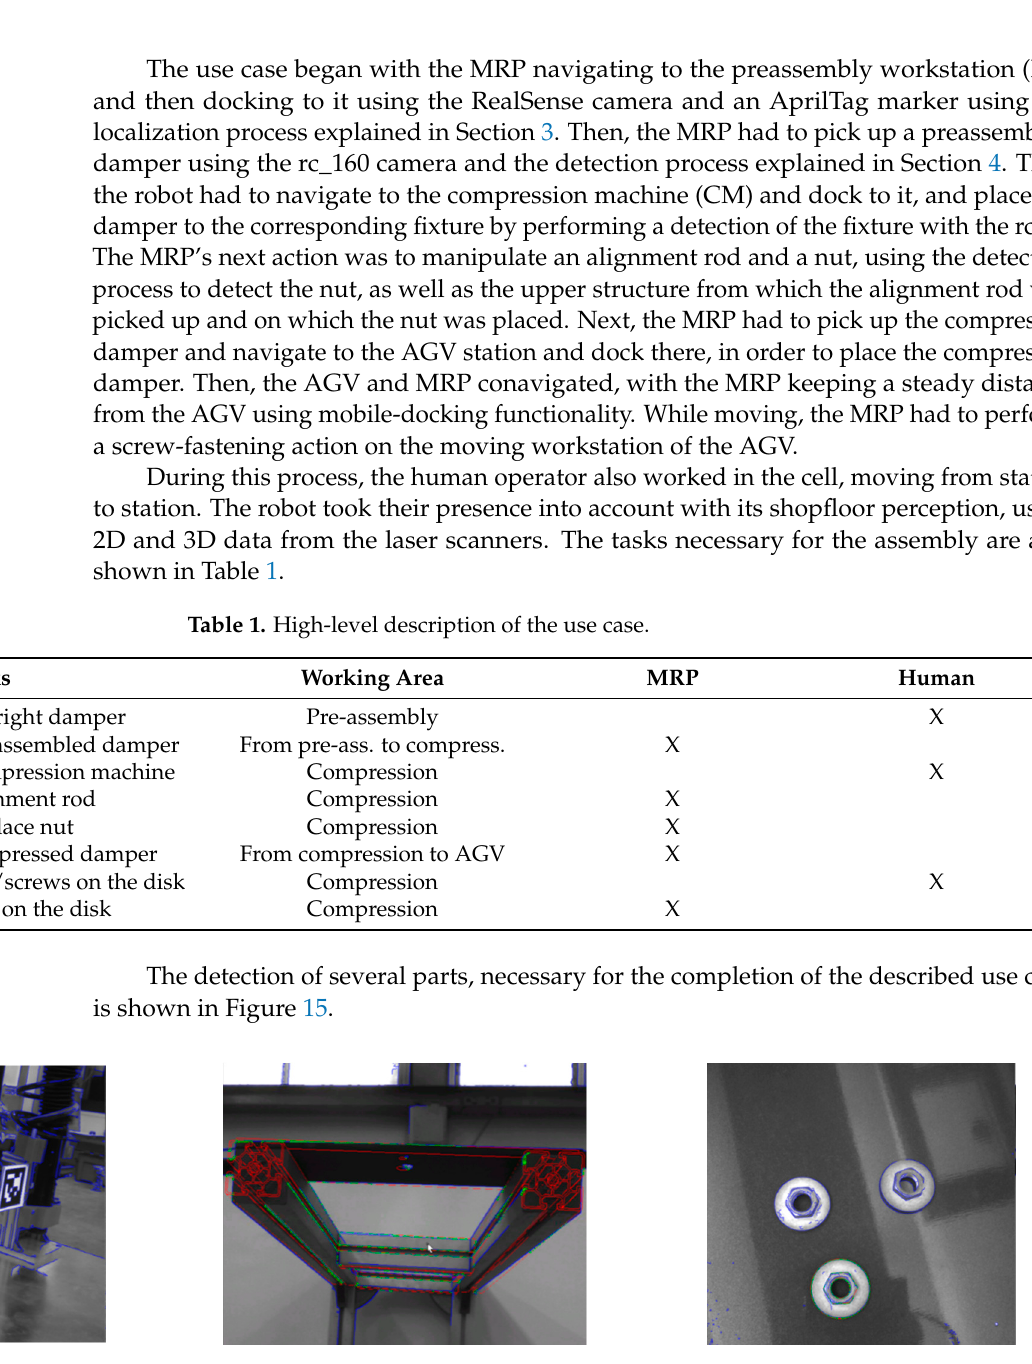
Figure 15. Detection of: ( a ) fixture, ( b ) nut, and ( c ) compression machine’s upper structure .